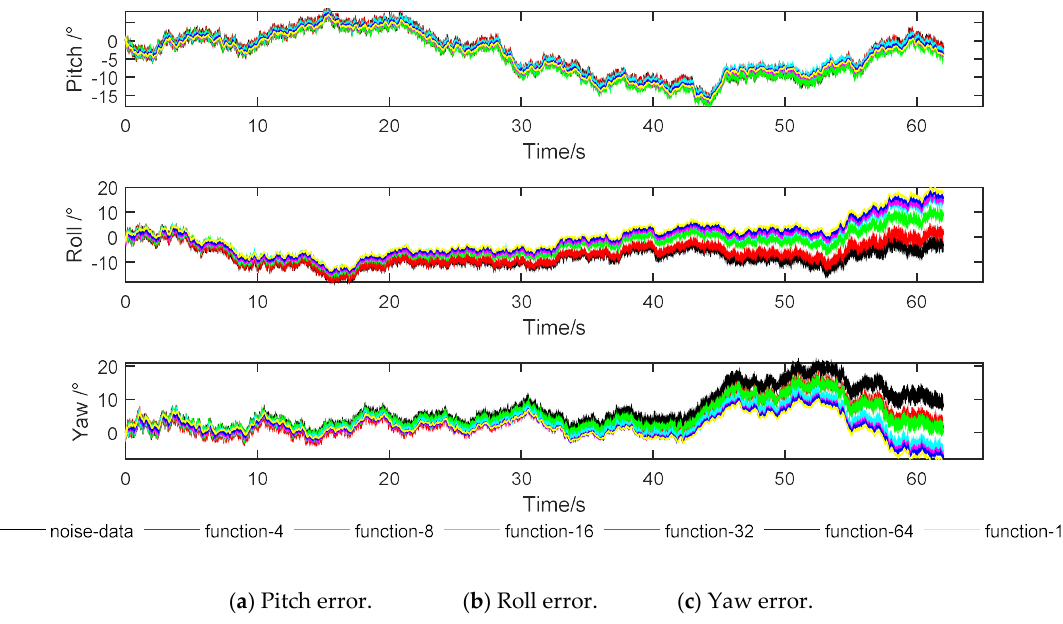
Figure 12. Attitude calculation error of different window length function extension. Table 4. AMAE and ARMSE results of different window length function extension (°).